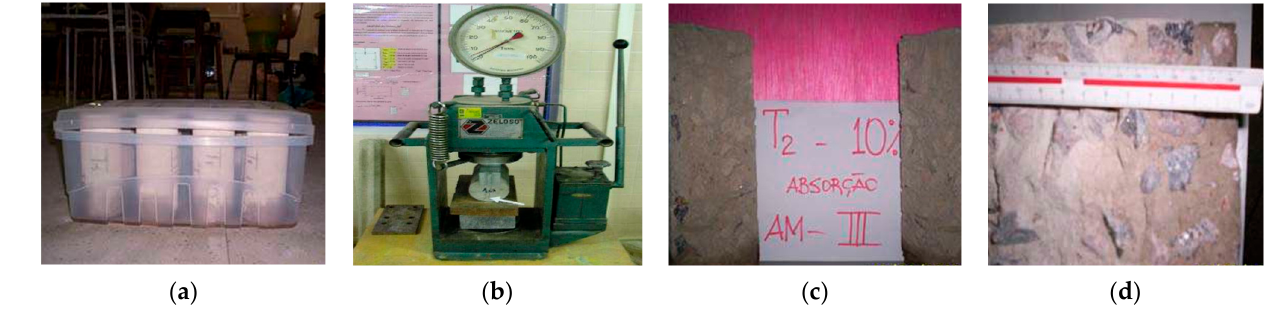
Figure 4. Capillary absorption test: ( a ) specimen immersed in water; ( b ) hand press; ( c ) broken specimen; ( d ) absorption by the specimen.